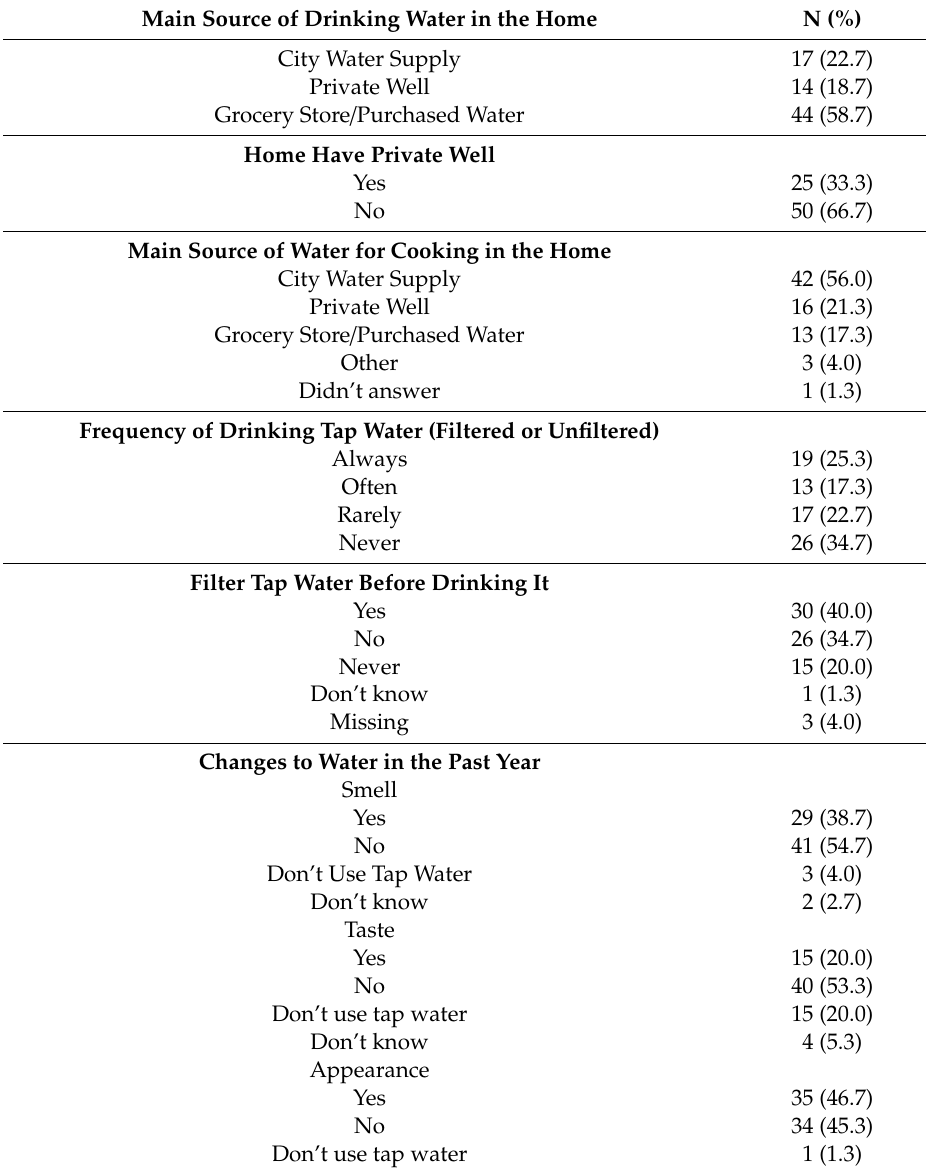
Table A1. Drinking Water Use and